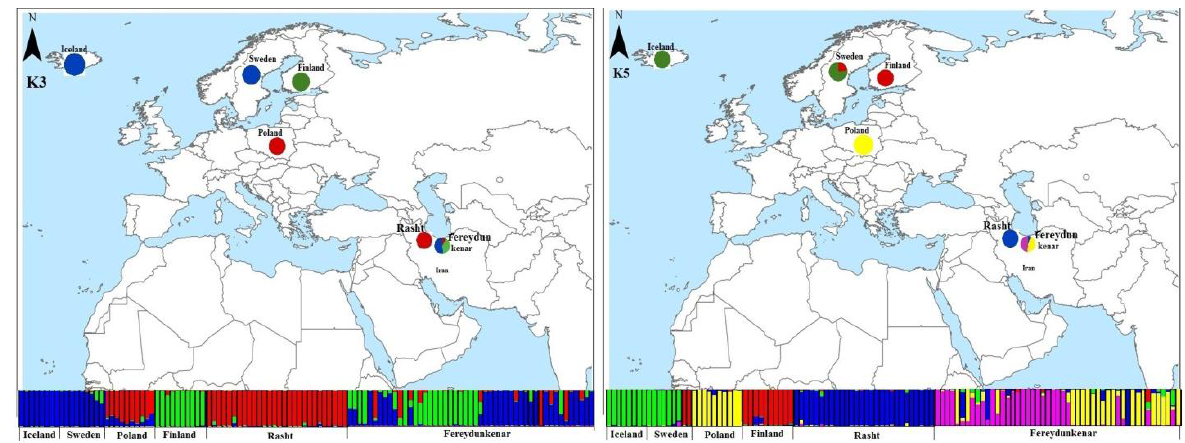
Fig. 1. Estimated population genetic structure based on allele frequency variation from 6 microsatellite loci as calculated in STRUCTURE. Each vertical bar represents an individual Whooper Swan partitioned into K genetic clusters (K= 3 and K=5), represented by unique colors. Population names are given below the figure.